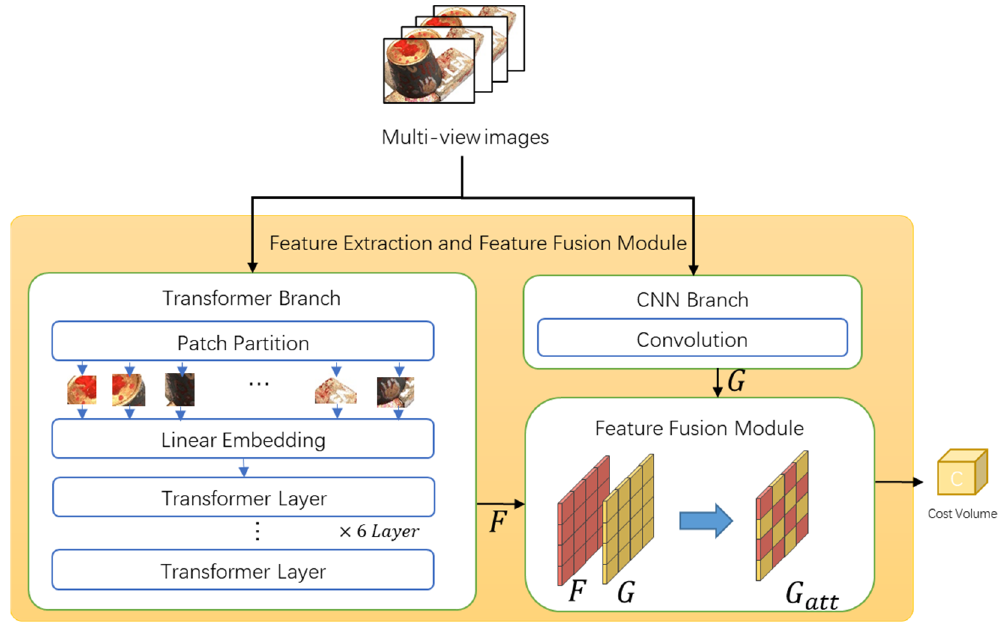
Figure 2. Overview of feature extraction net.